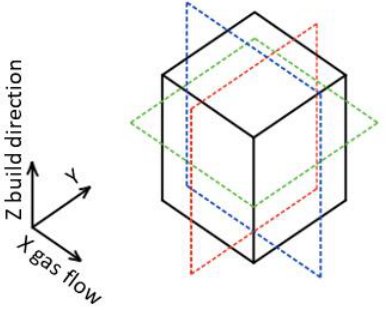
Figure 2. Cutting planes used for samples preparation.